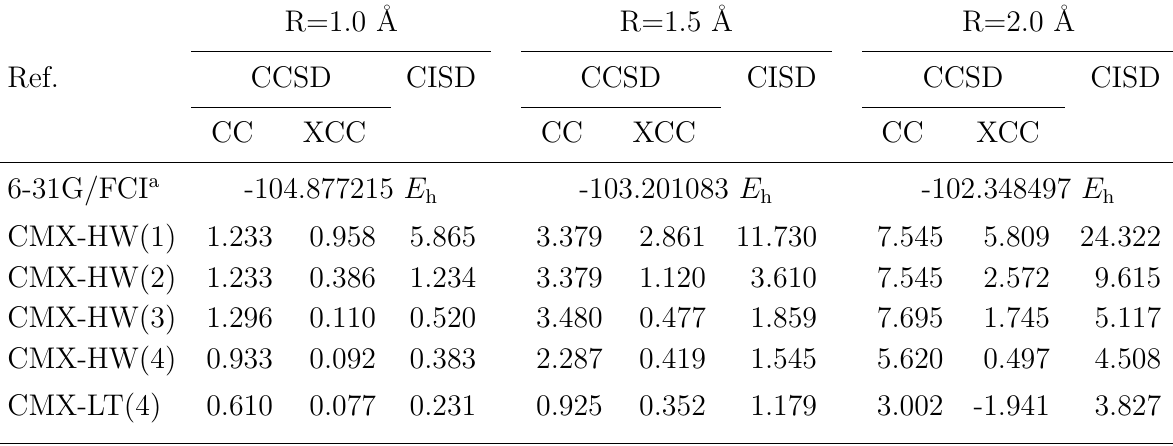
Table 3: Deviations of the CMX energies (in m E h ) from the full CI energies for the HF molecule. R=1.0 ˚A R=1.5 ˚A R=2.0 ˚A